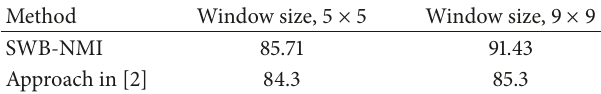
Table 1: Percentage of changes using SWB-NMI for different window sizes (1st dataset).